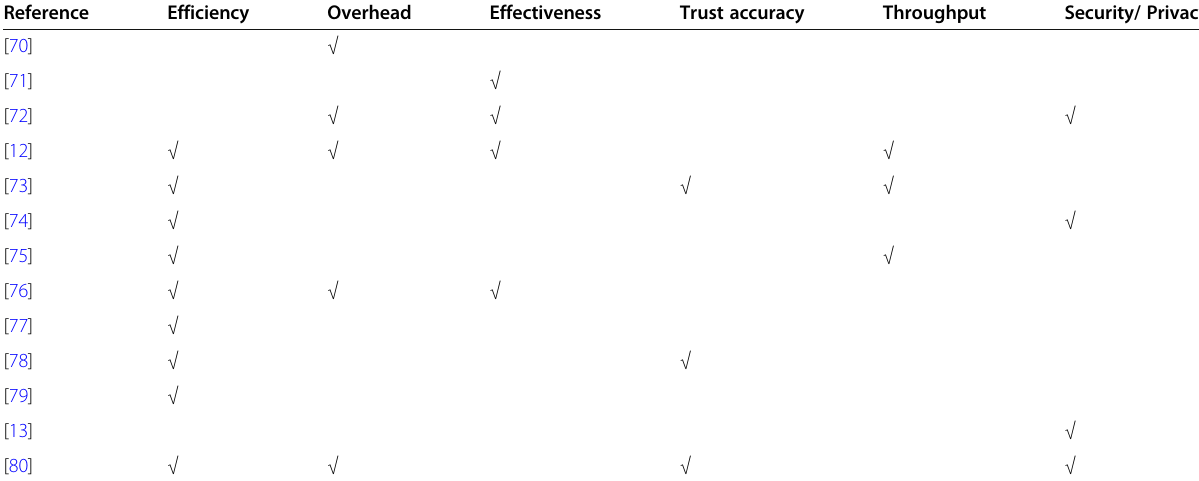
Table 5 Comparison of performance test